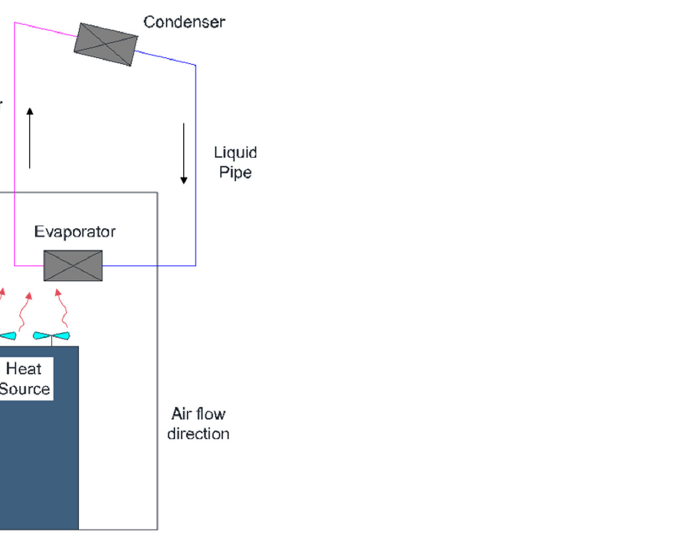
Figure 11. Thermosiphon circuits in outdoor racks for cooling telecommunications equipment [62].